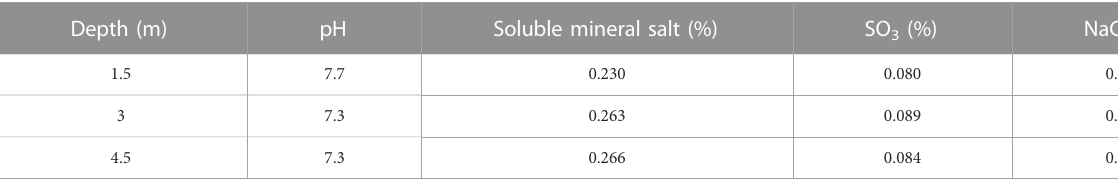
TABLE 3 Chemical analysis of Najran soils. Depth (m)